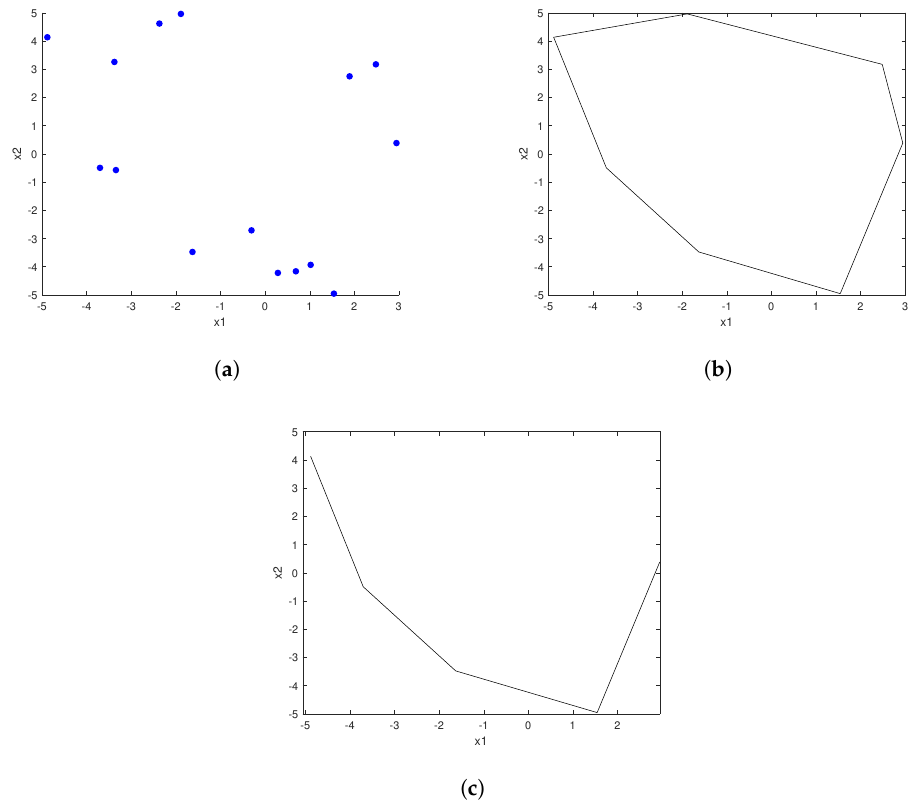
Figure 4. Constructing the convex function landscape when d = 2, N = 15. ( a ) Randomly generated points. ( b ) Constructed convex hull. ( c ) The curve after removing the upper